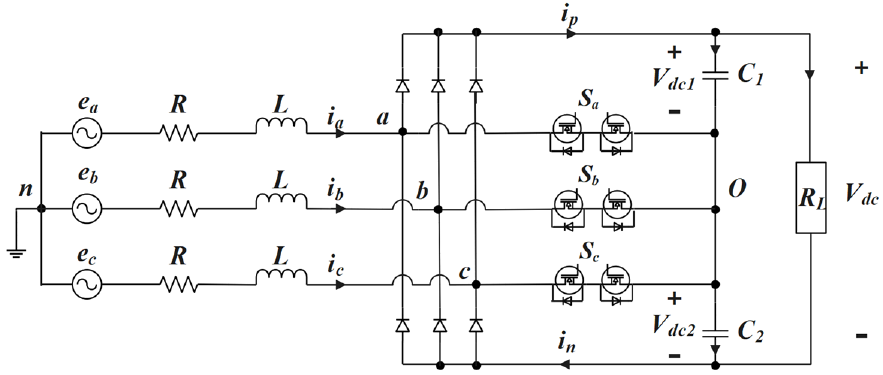
Figure 1. T type Vienna rectifier topology [20].